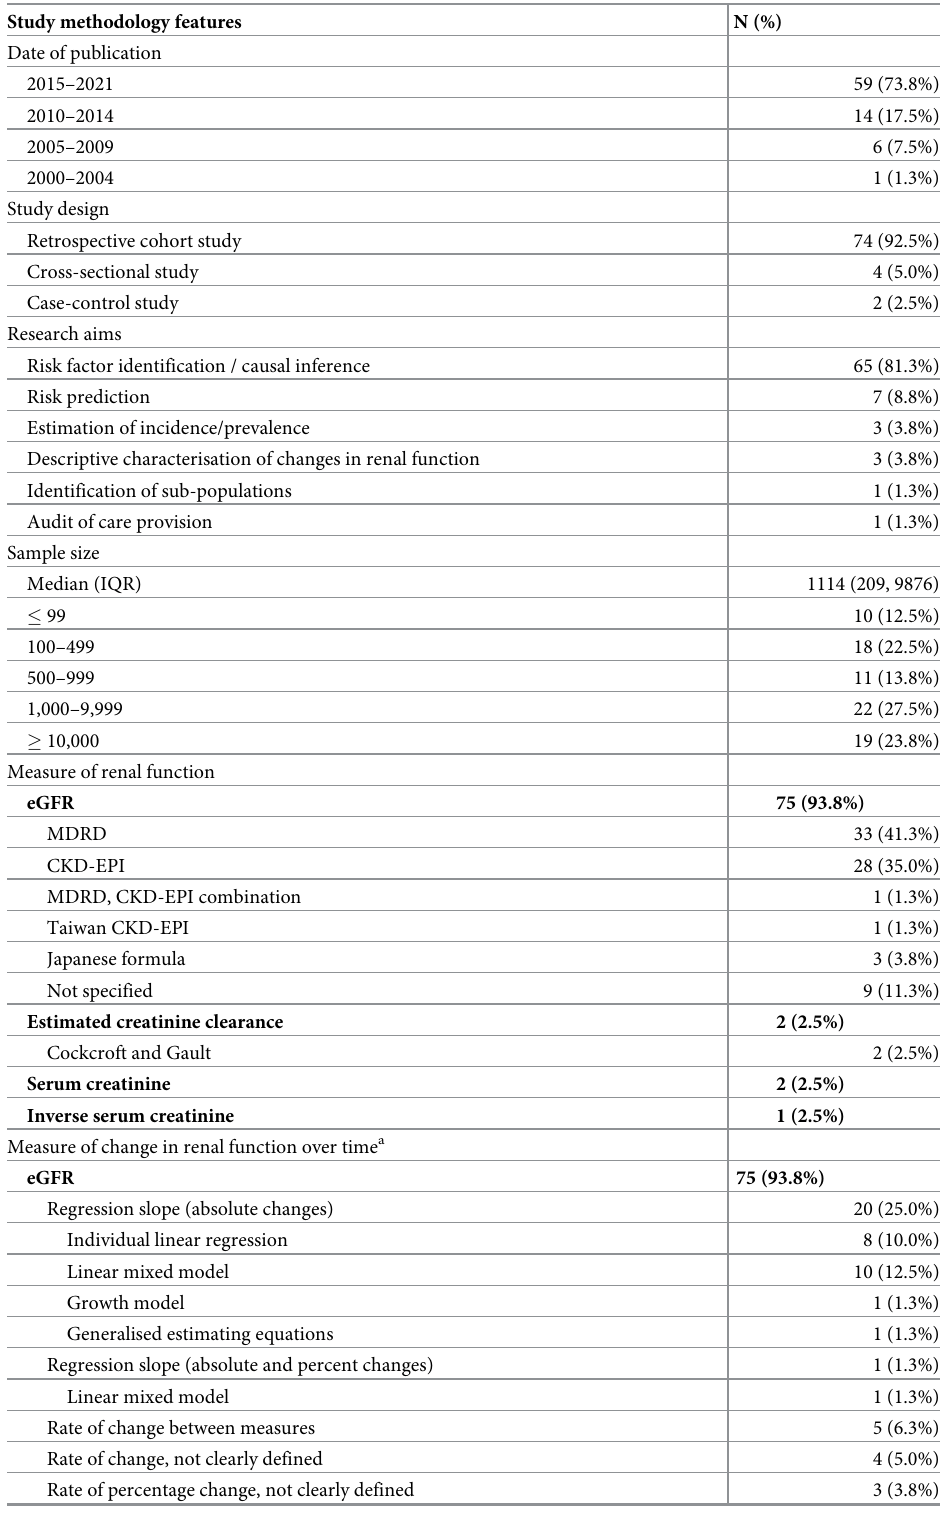
Table 2. Study methodology (N =